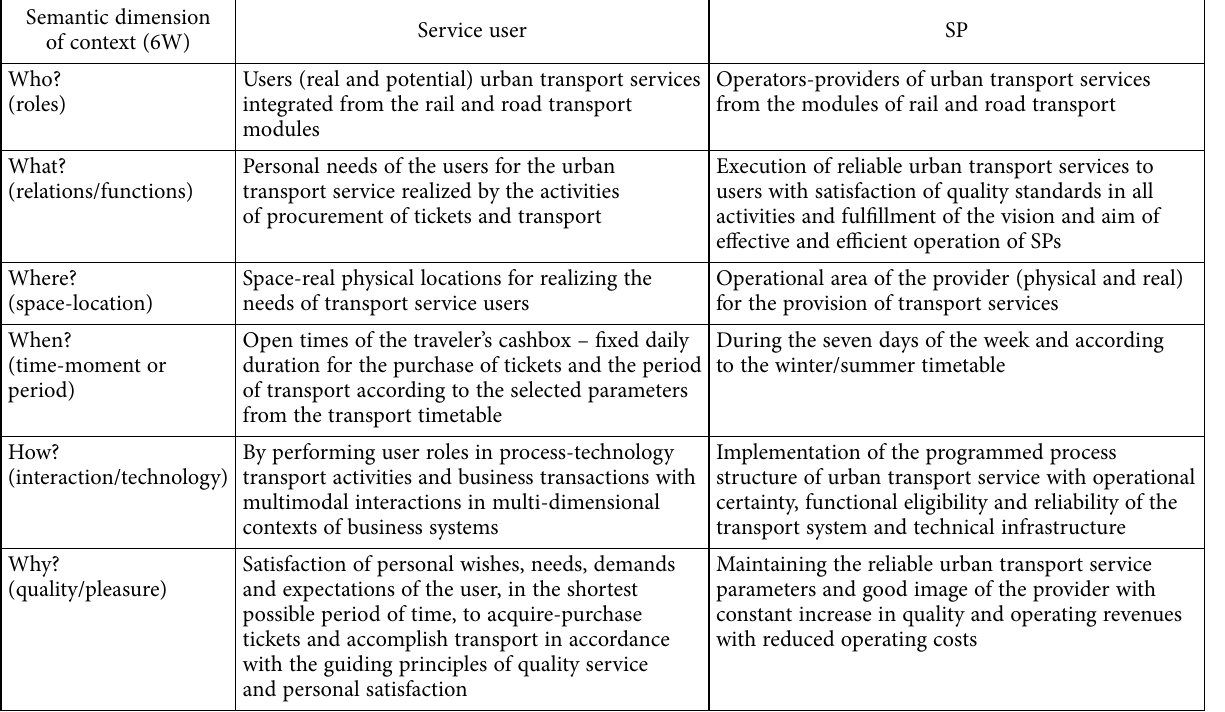
Table 1. Semantic dimensions of the context coupled with the situational factor of the dynamics of business communication Semantic dimension of context